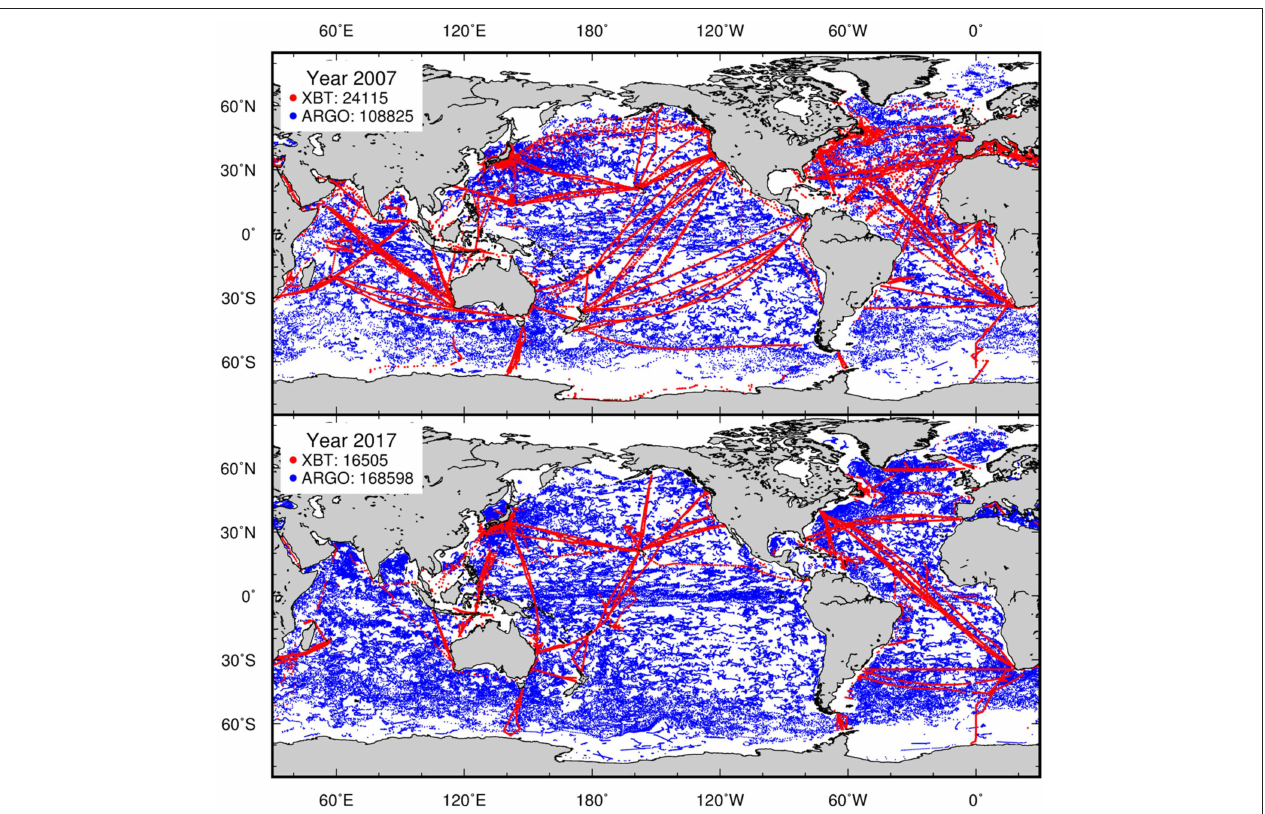
FIGURE 2 | Location of XBT (red) and Argo float (blue) measurements during the years 2007 (Top) and 2017 (Bottom) that show the difference of spatial sampling produced by these observing platforms. The numbers indicate the observations made by each platform during these 2 years. and monitoring the state of the ocean, particularly with respect to the MOC, OHC, and sea level change, and extreme weather events, are also